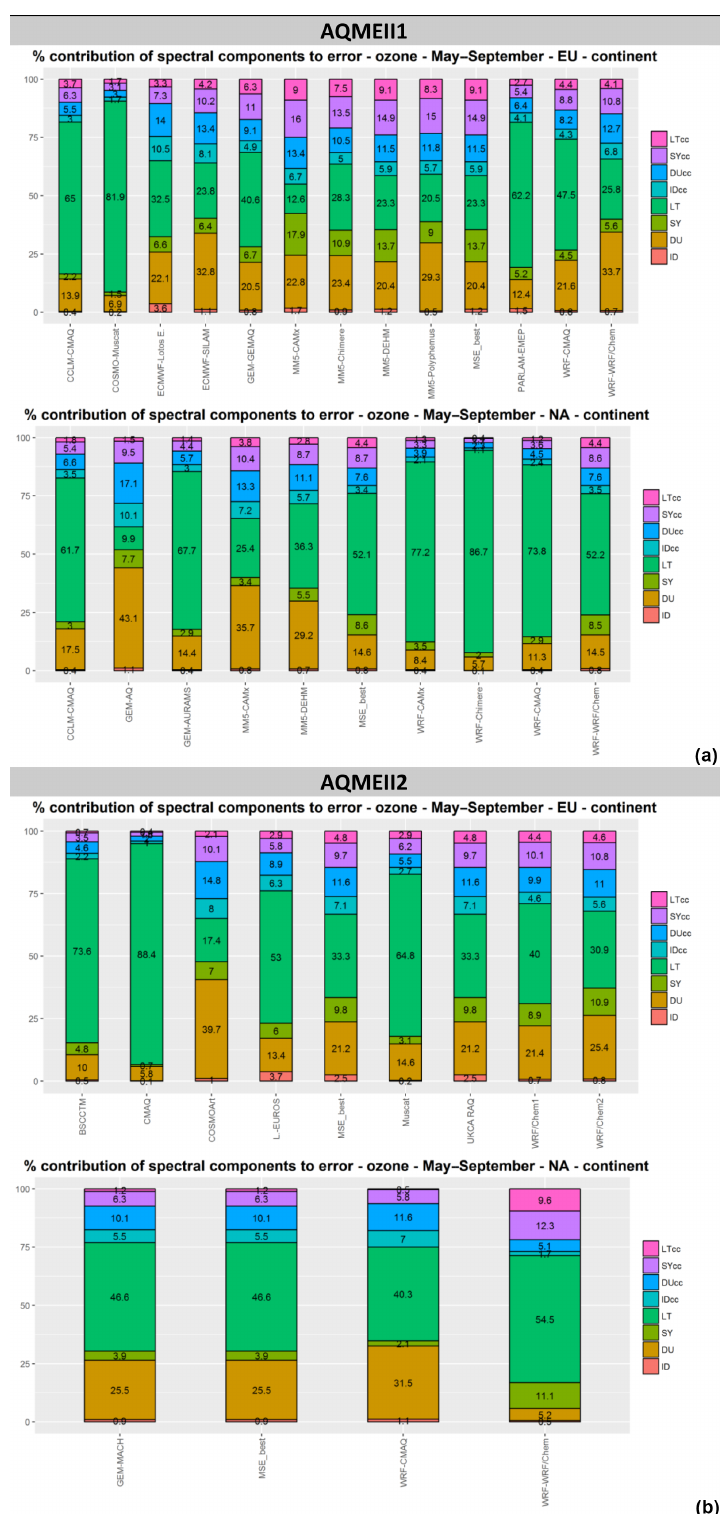
Figure 1. Share (in %) of the total MSE in the main spectral components and the cross-components (see Appendix for detail) for (a) AQMEII1 and (b) AQMEII2. Top panel: EU; lower panel: